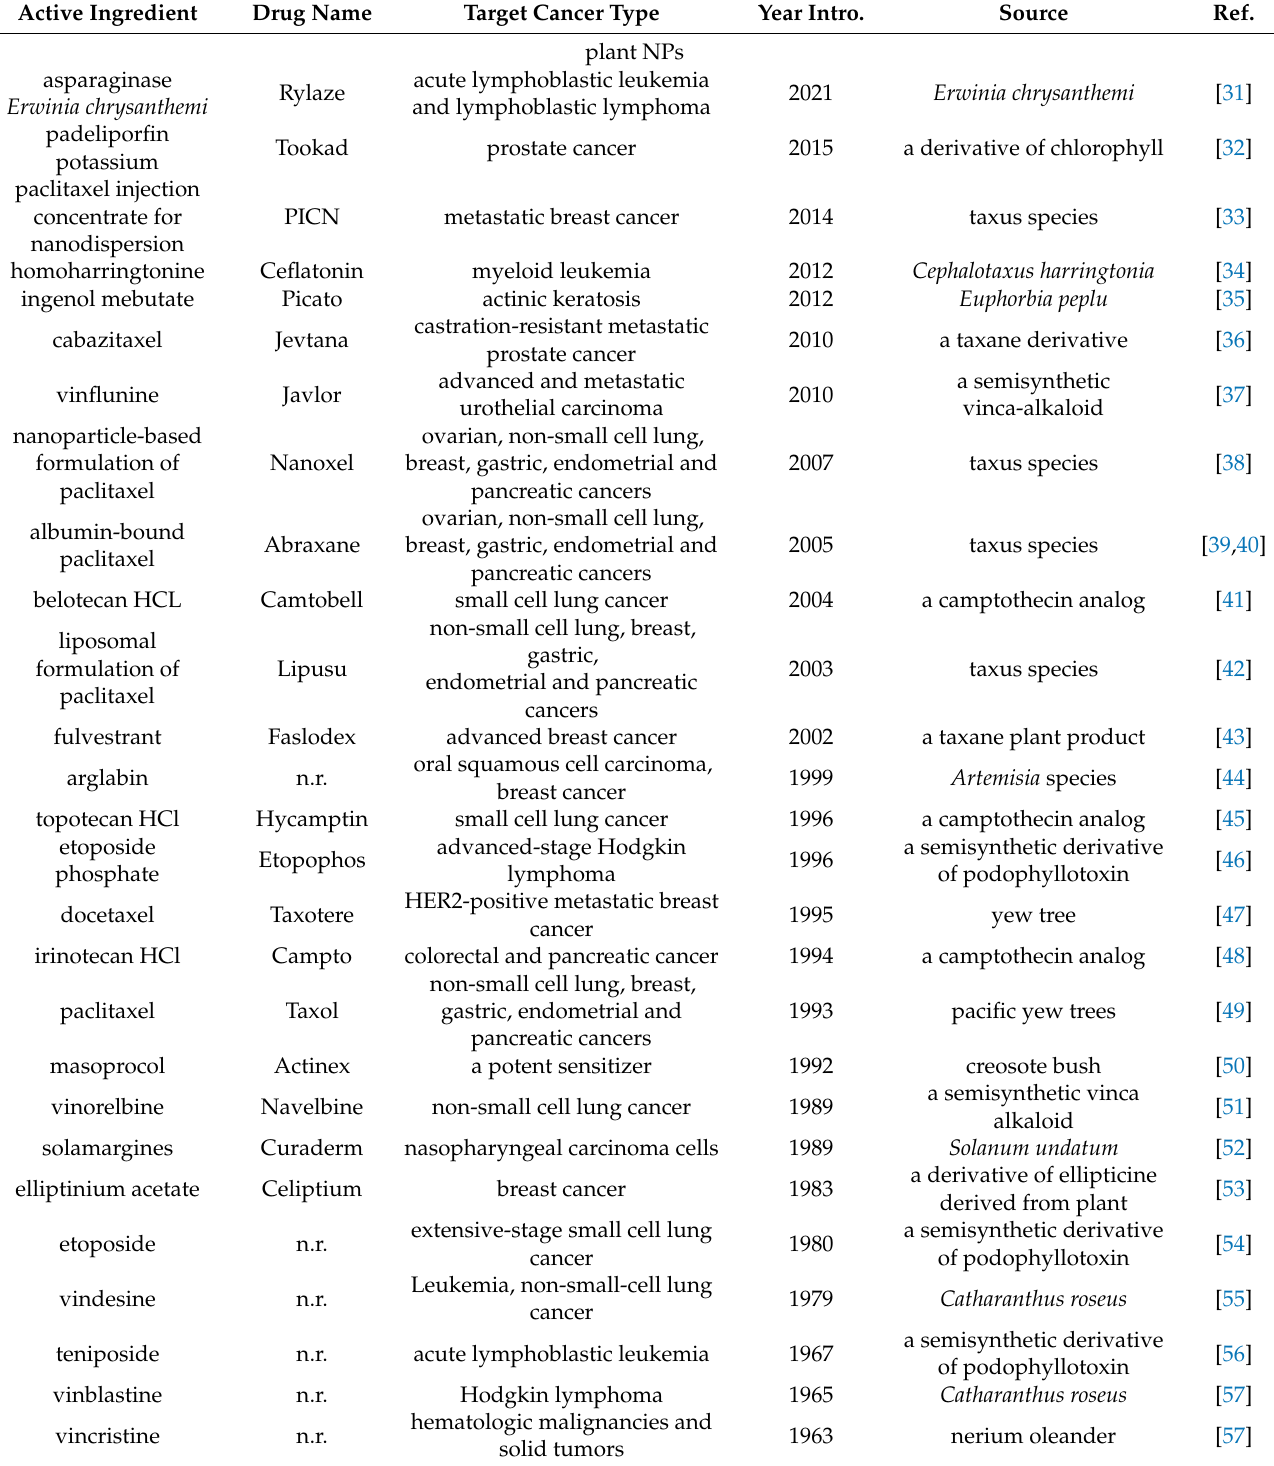
Table 1. All natural anticancer drugs approved from 1950 to